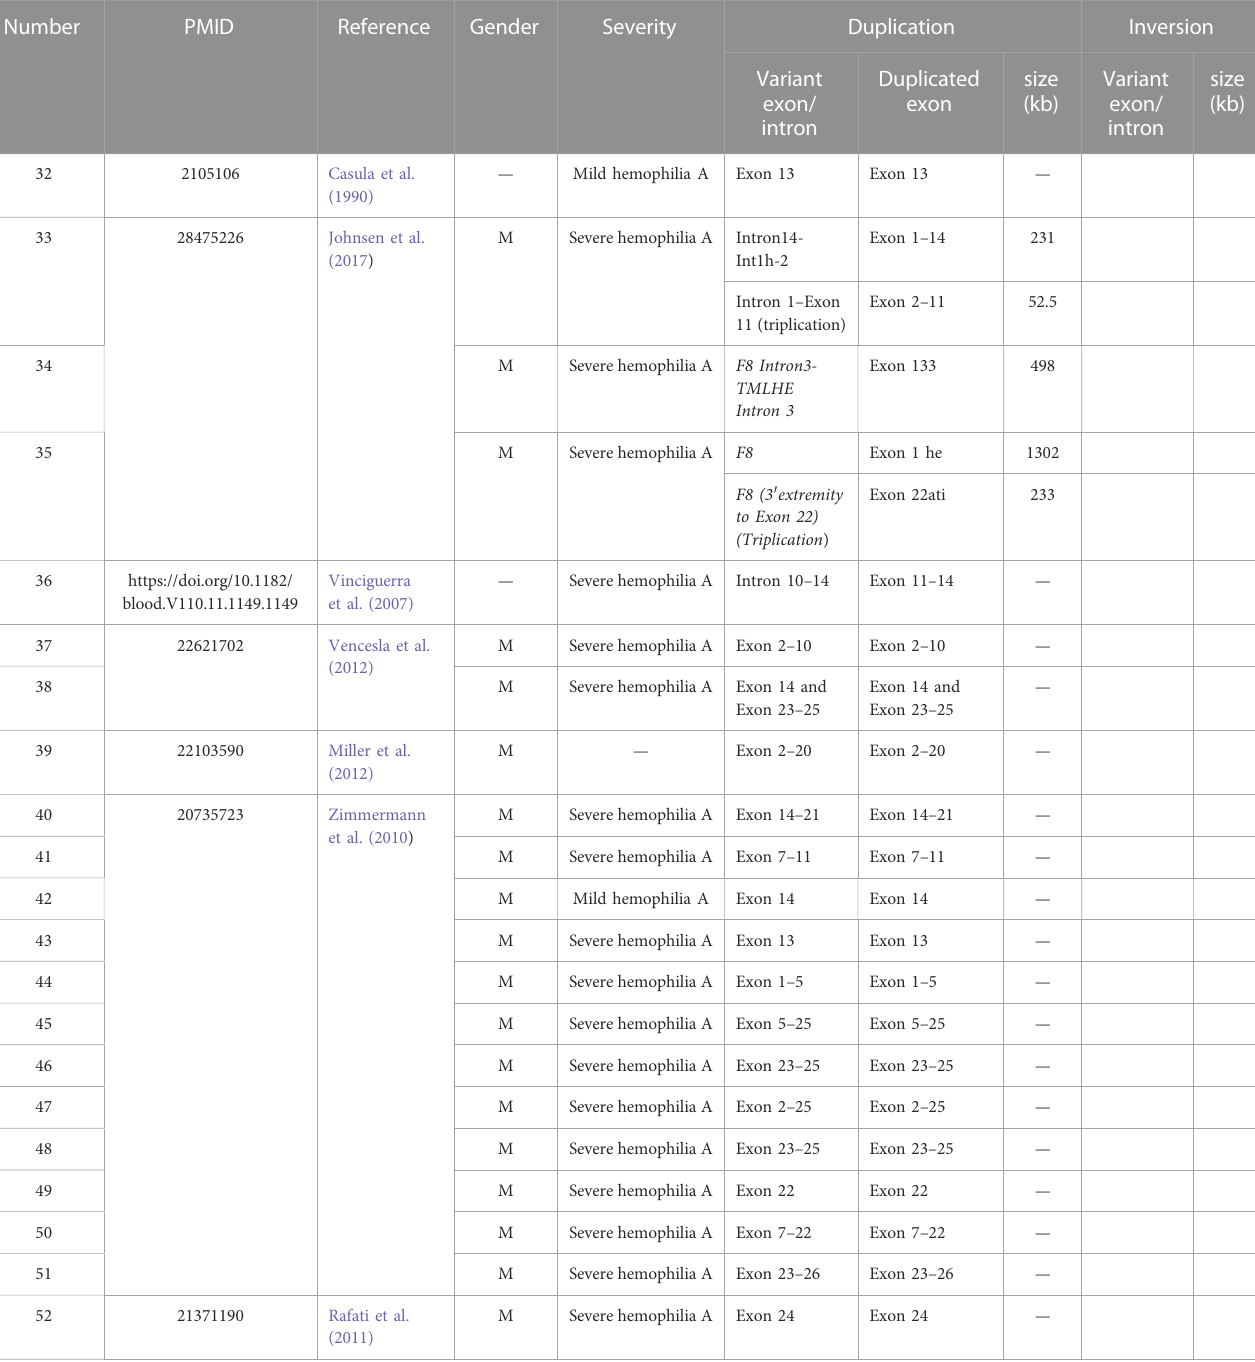
Values in the eighth column refer to the sizes of the duplication regions